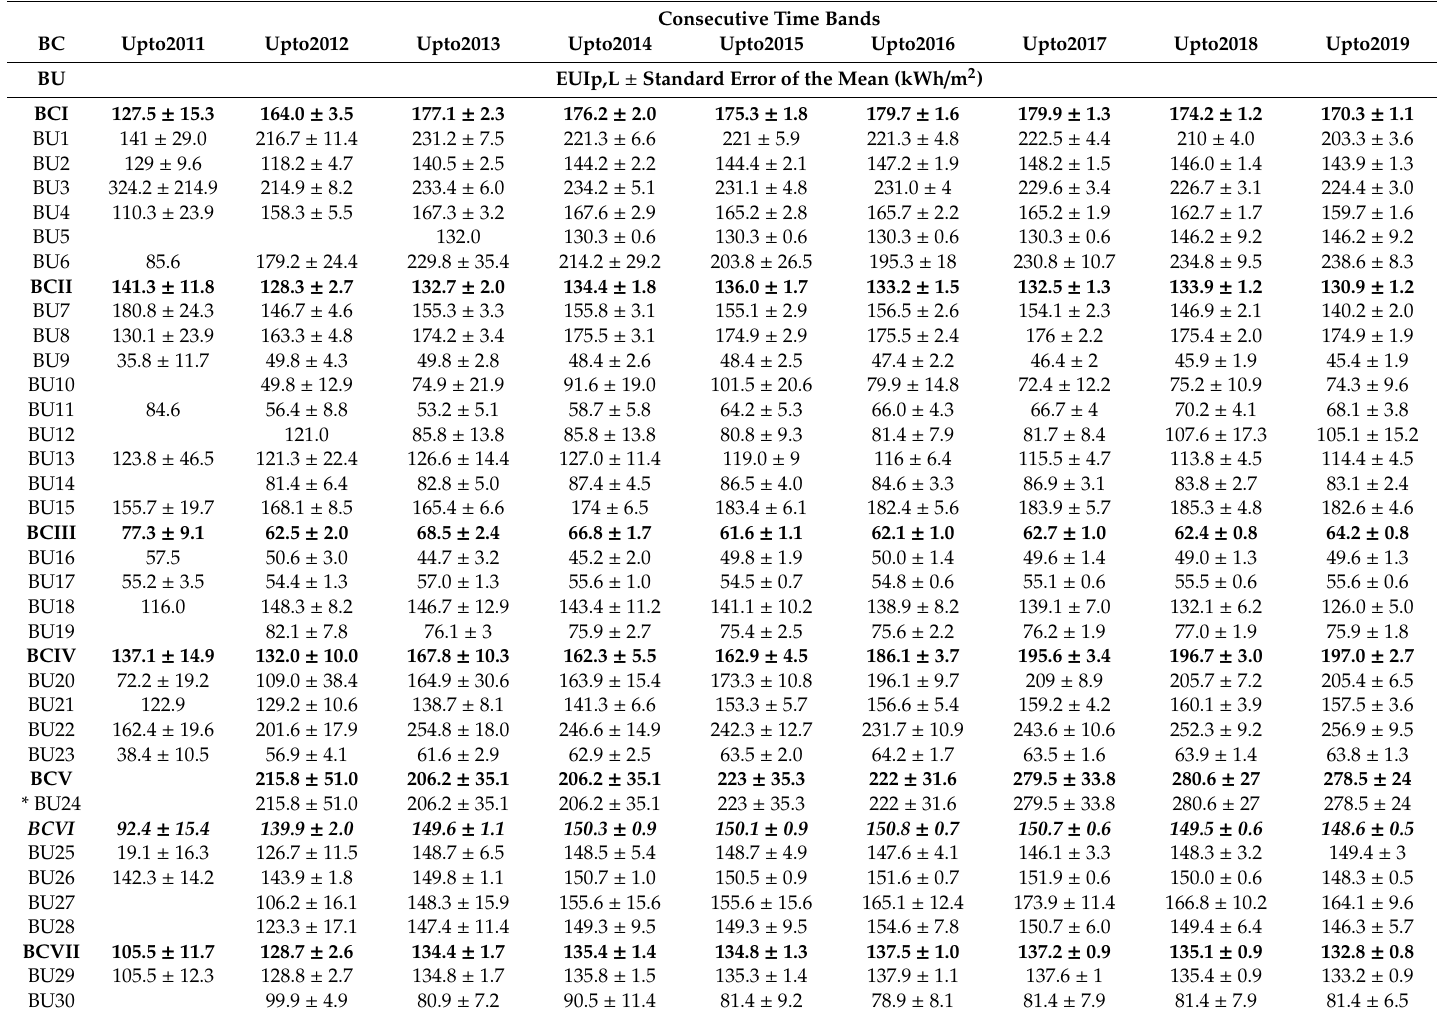
Table 6. Time evolution of calculated average primary energy use for lighting for the di ff erent building categories and building uses in the NR